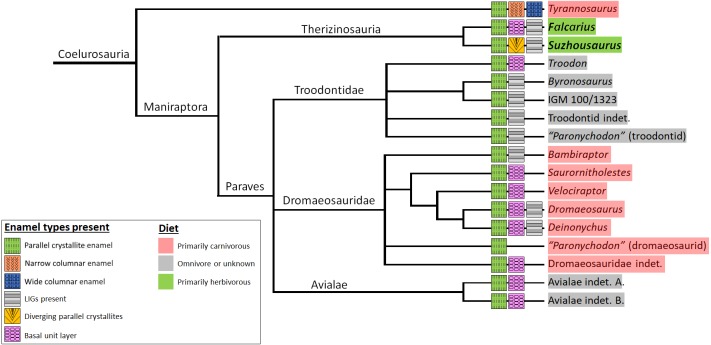
Diet and schmelzmuster in coelurosauria.Homoplasy is widespread, and parallel crystallite enamel is commonplace across the clade. Schmelzmuster does not appear to strongly reflect diet or phylogenetic position within the clade. Therizinosaurians possess simplistic enamel with no columnar units, and with basal unit layer only detectable in UMNH VP 15231. Enamel crystallites in Suzhousaurus are slightly divergent. Data from Hwang (2011). Phylogeny from Cau, Brougham & Naish (2015).